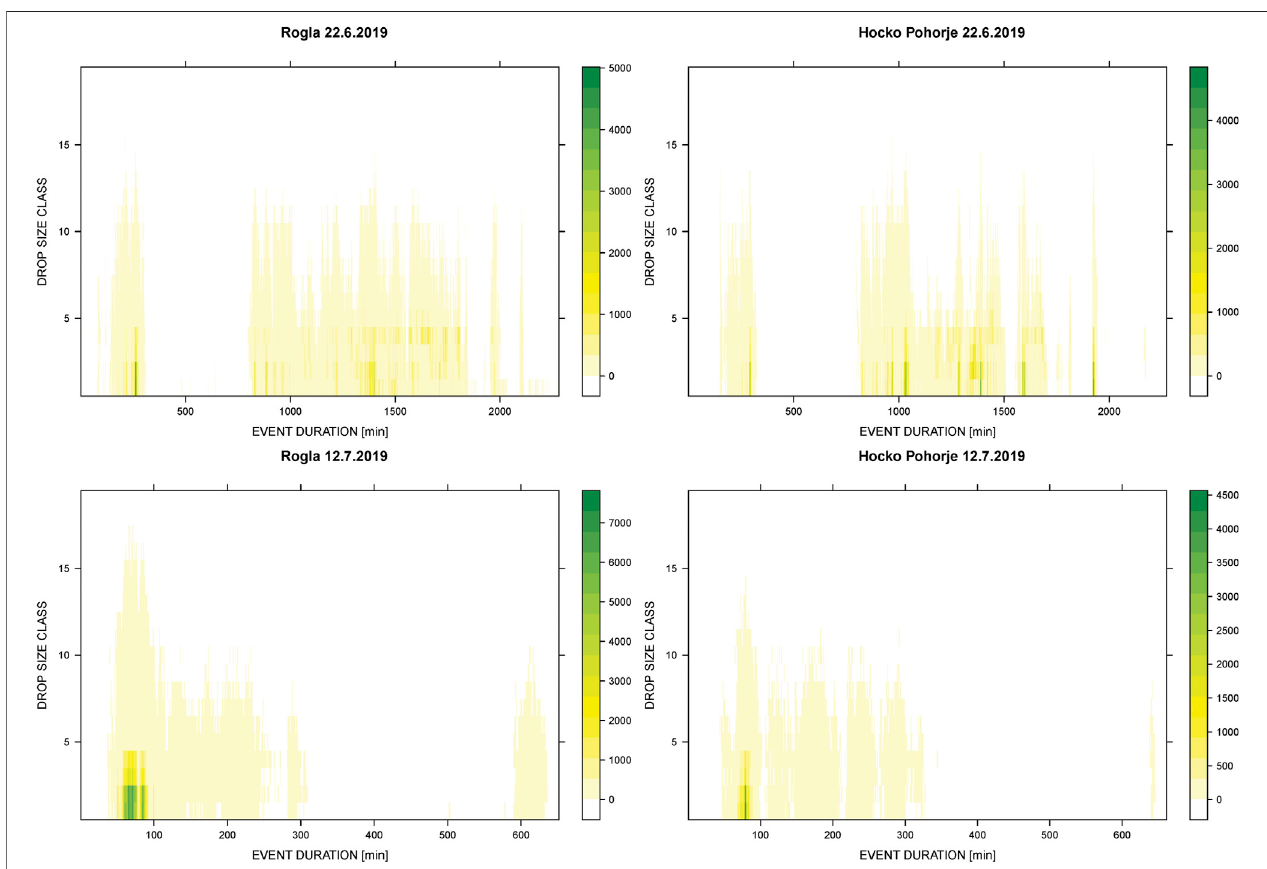
FIGURE 7 | Two rainfall events with different characteristics that occurred at Rogla and Ho č ko Pohorje stations. The fi rst event started on June 22, 2019, at 9:00 and the second event on July 12, 2019, at 17:00. The x -axis shows event duration in minutes, the y -axis shows 19 diameter classes, and the color scale indicates the number of detected raindrops per diameter class during the event.